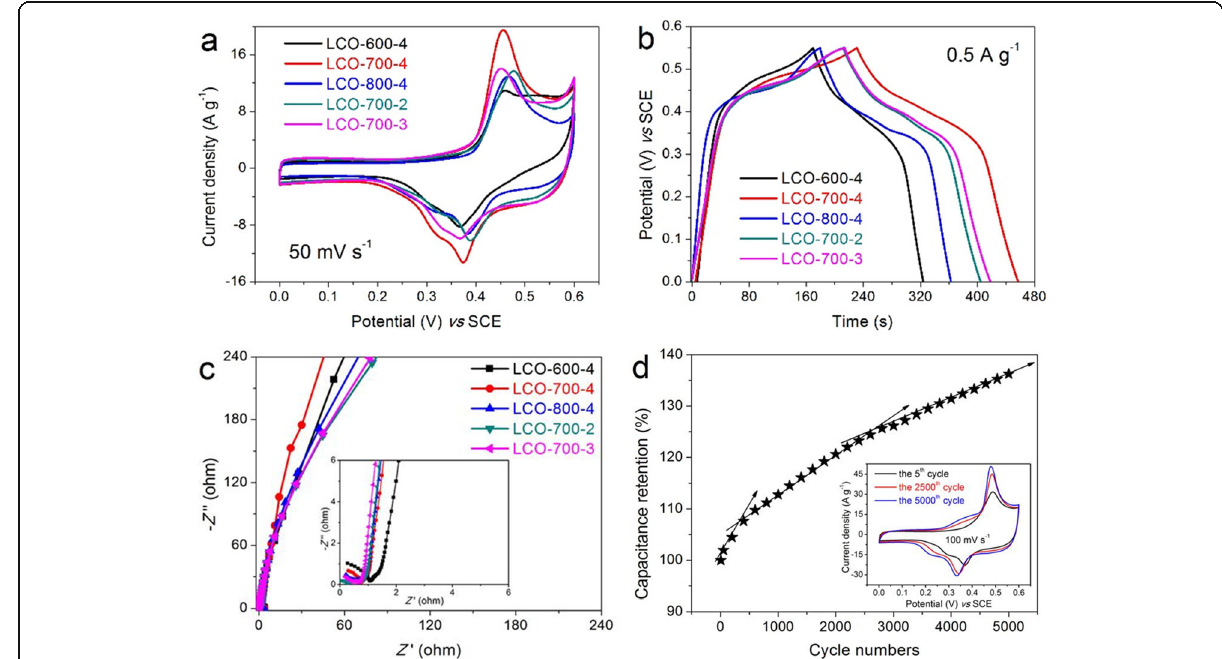
Fig. 2 a CV curves at 50 mV s − 1 , b GCD curves at 0.5 A g − 1 , and c Nyquist plots in the frequency range of 100 kHz to 0.01 Hz for all prepared LCOs electrodes at different calcination temperatures and times. d Cycling stability of LCO-700-4 electrode at 100 mV s − 1 for 5000 cycles (insert shows the comparison of CV curves at 5th cycle, 2500th cycle, and 5000th